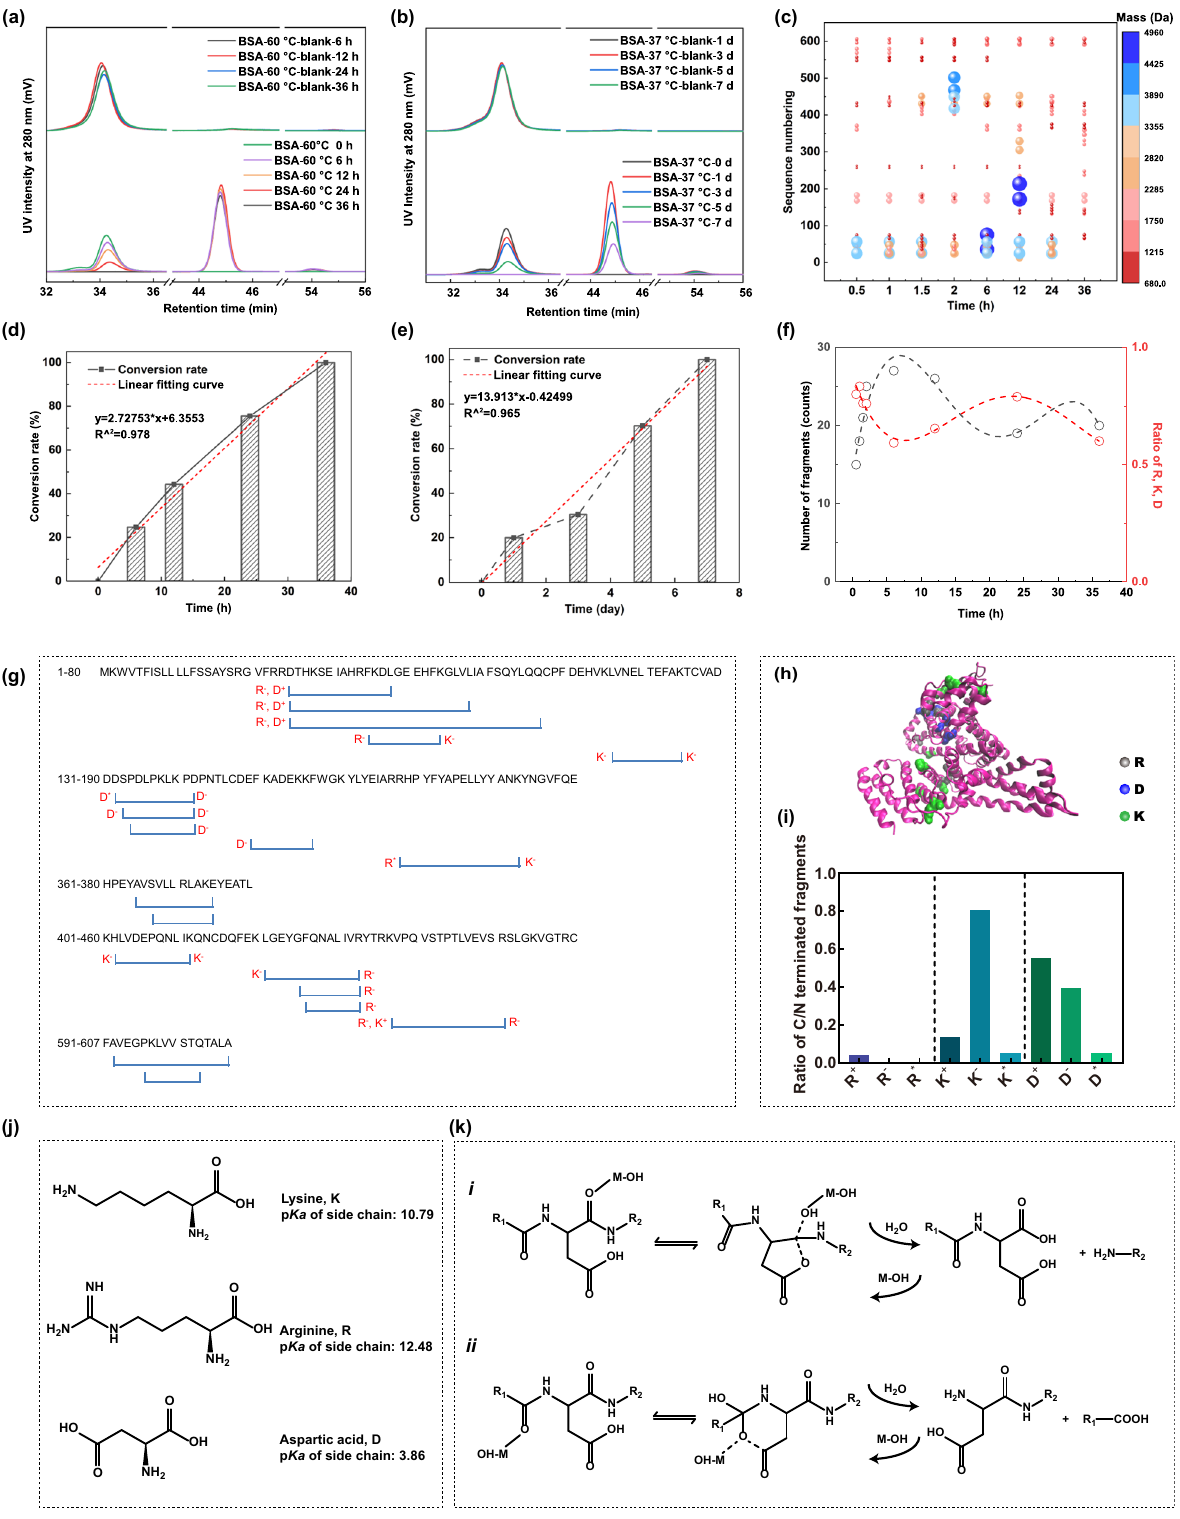
globular protein with 585 amino acids (66.4 kDa molecular weight). To monitor the hydrolysis of BSA, gel permeation chromatography (GPC) with UV detection at 280 nm was used. The peak corresponding to BSA at 34 – 36 min decreased gradually as the reaction proceeded in PBS (pH 7.2 – 7.4) at both 60 °C and 37 °C, see the lower curves in Fig. 4a, b; while there is no noticeable self-degradation product in the absence of Ce-FMA-